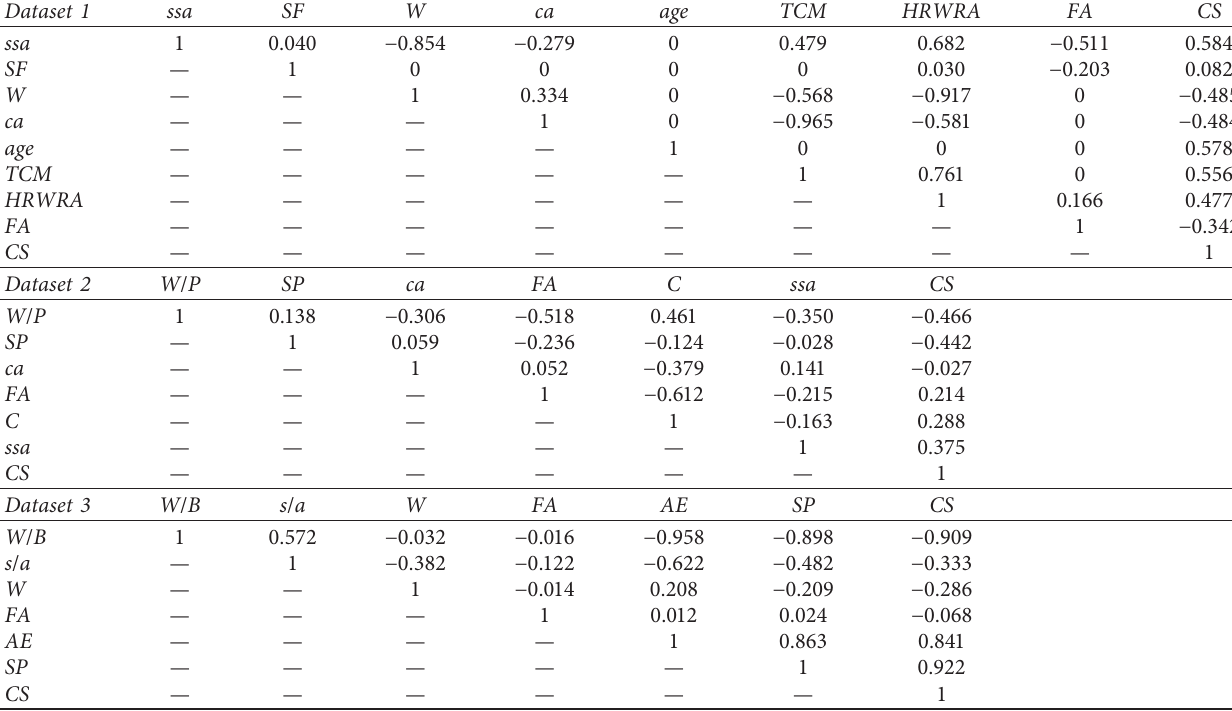
Table 3: Correlation matrices of concrete datasets.